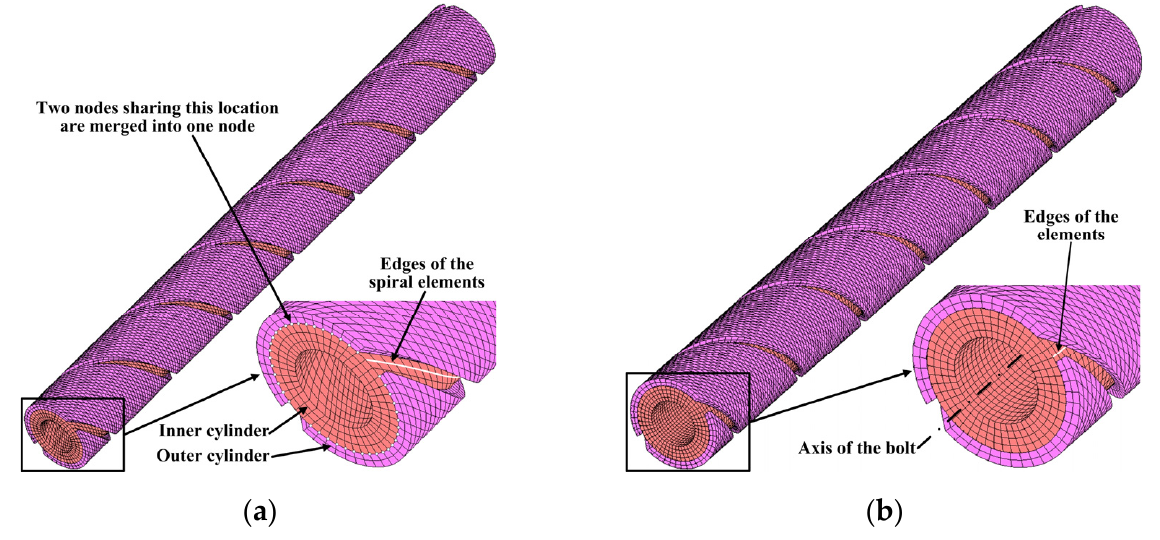
Figure 7. Finite element model of the bolt: ( a ) the inner cylinder is connected with the outer cylinder by merging nodes; ( b ) the inner cylinder is connected with the outer cylinder by gluing contact.